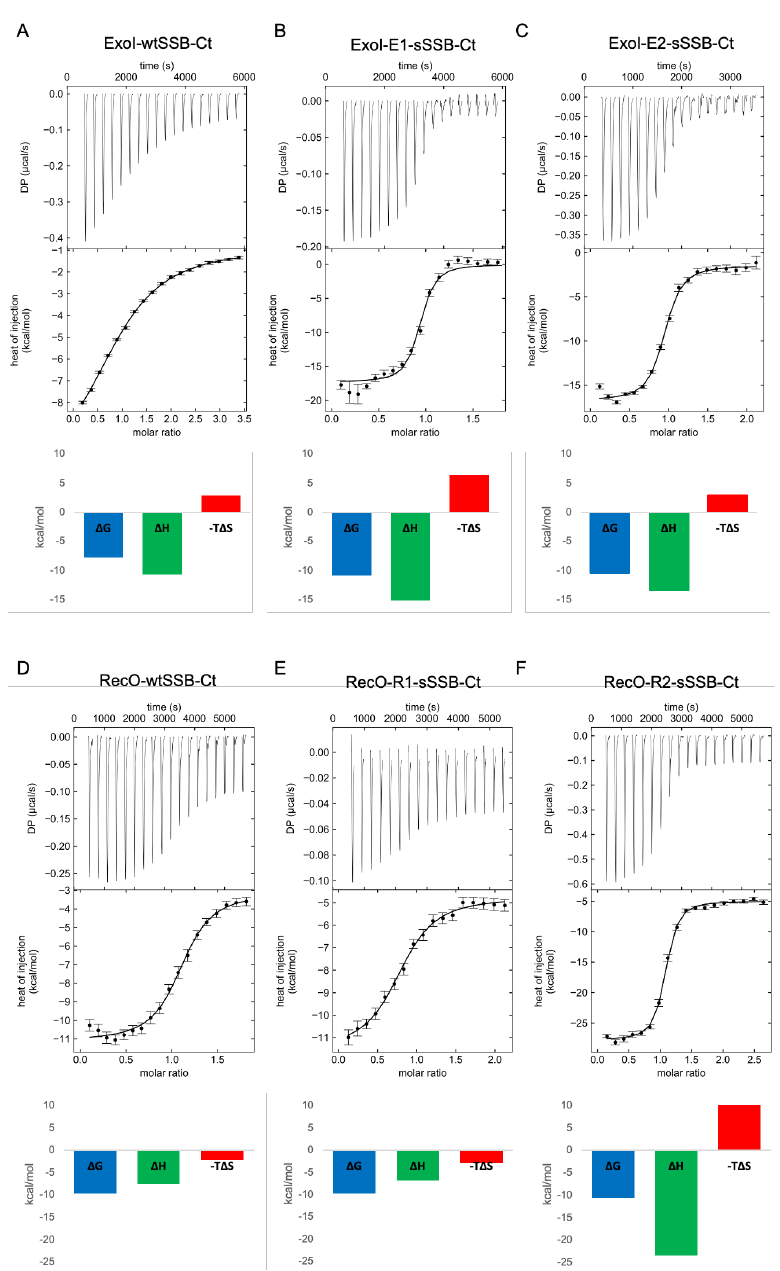
Figure 7. Thermodynamic profiles of binding to ExoI and RecO for the wild-type and modified SSB-Ct sequences. ITC data for ExoI titrated with wtSSB-Ct ( A ), E1-sSSB-Ct ( B ), and E2-sSSB-Ct ( C ). ITC data for RecO titrated with wtSSB-Ct ( D ), R1-sSSB-Ct ( E ), and R2-sSSB-Ct ( F ). The reconstructed thermograms displayed were obtained after global peak-shape analysis and singular value decomposition regularization implemented in the NITPIC program.